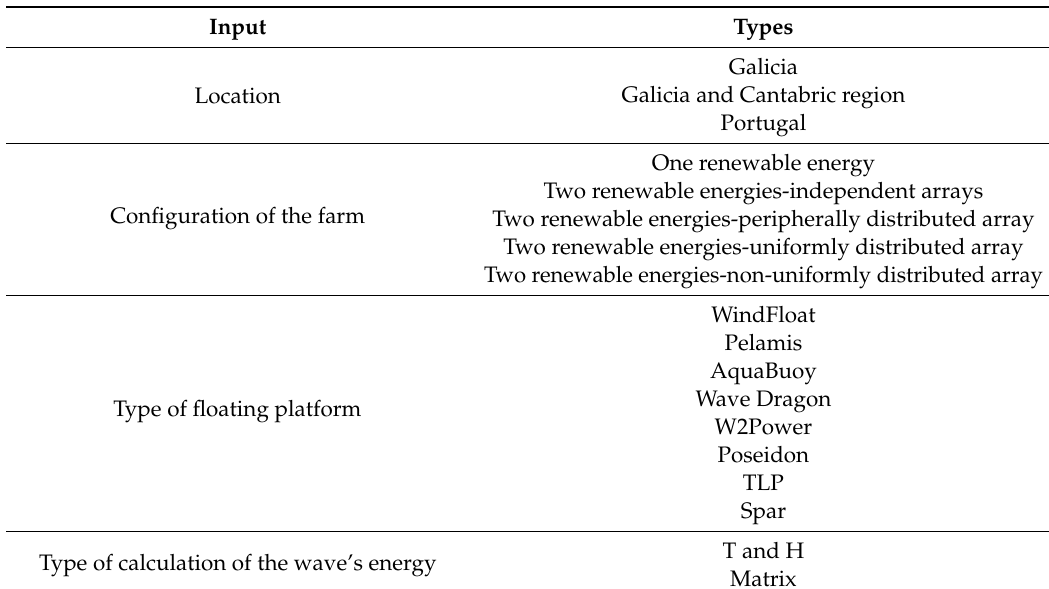
Table 1. Inputs of the software I. TLP- tensioned leg